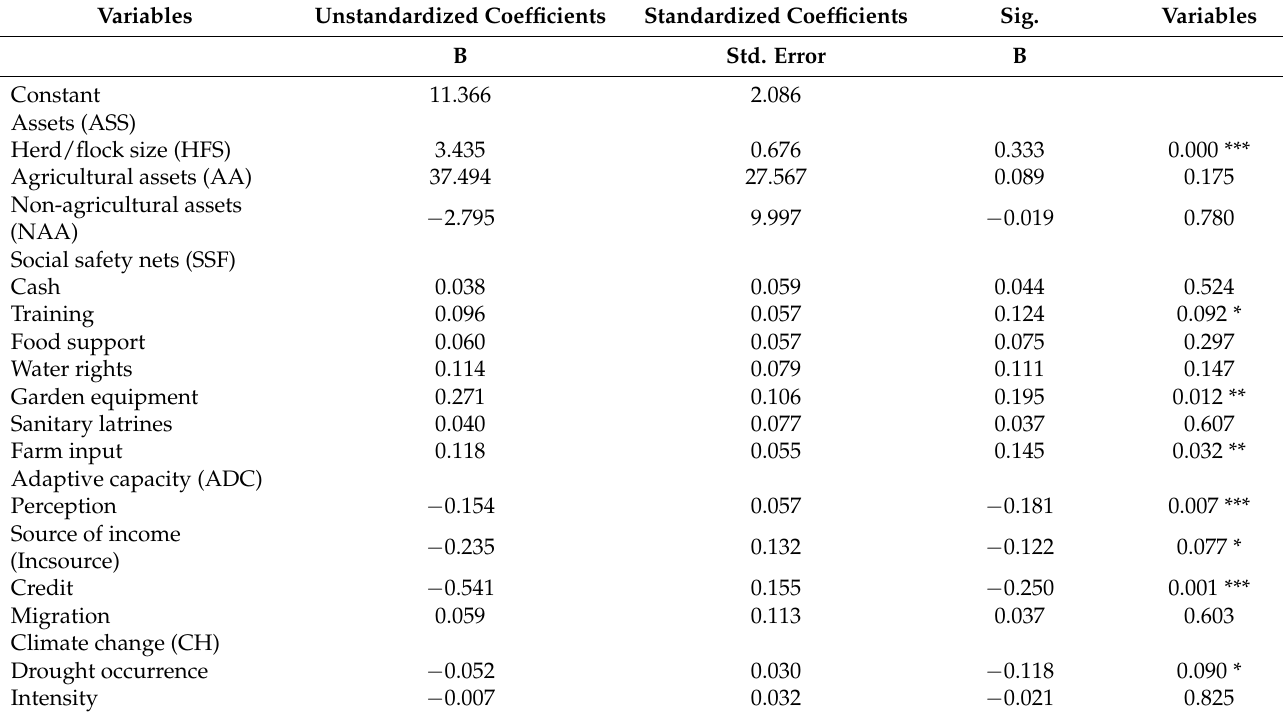
Table 7. Structural equation modeling results